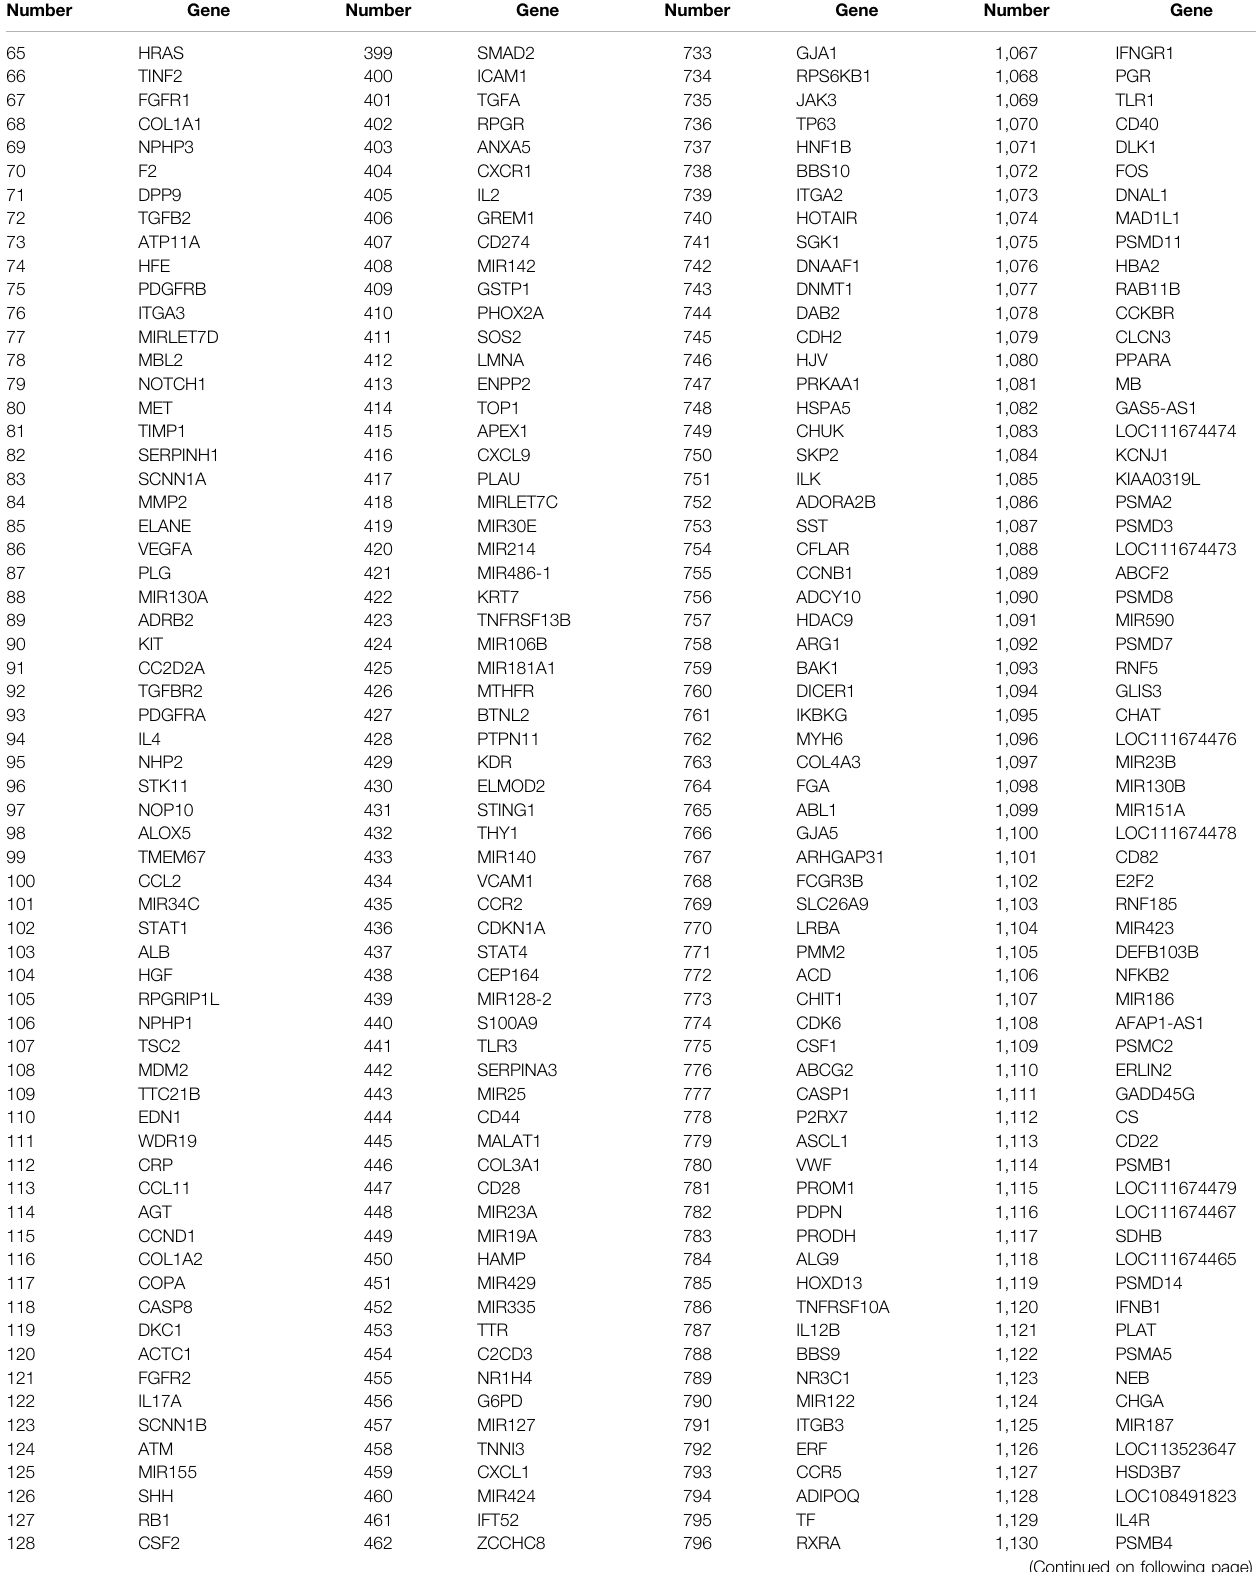
TABLE 3 | ( Continued ) Lung fi brosis-related targets obtained from the GeneCards